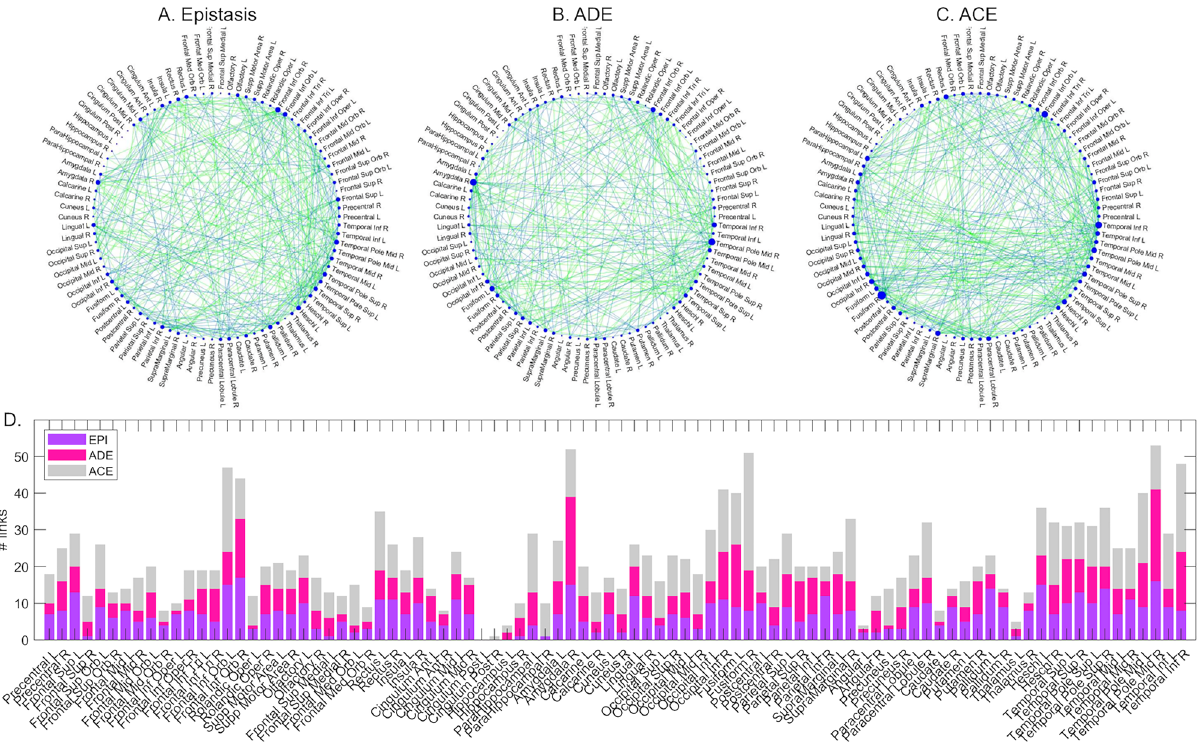
Figure 2. Twin models on link-level FC metrics. A-C. Graphs representing the brain functional connections influenced by epistasis ( A ), ADE factors ( B ), and ACE factors ( C ). Intra-hemispheric and inter-hemispheric connections are represented in blue and green, respectively. The size of each ROI (node) in the graph is proportional to the number of ROI connections influenced by the corresponding factor. D. Stacked bar plot representing the numbers of links per node influenced by epistasis (violet), ADE factors (magenta), and ACE factors (grey). FC: functional connectivity. ROI: region of interest. Panels were created with Matlab R2019b software (http:// www. mathw orks. com), assembled with Microsoft Power Point software (https:// www. micro soft. com/ it- it/ micro soft- 365/ power point) and exported using GIMP v.2–10 (https:// www. gimp. The comparison between r MZ and r DZ values based on Fisher’s Z-transform revealed significant differences, even if at the uncorrected level (p unc < 0.05), in 13.79% of the network links showing epistatic effects (highlighted in blue for the top 20 ROIs in Fig. 3A). Right middle temporal pole was the ROI with the highest number of links being significantly more correlated in MZ twins than in DZ twins (n = 11). The highest correlation difference was observed in the connection between right middle temporal pole and right precentral gyrus (Z = 2.94, p = 0.0016). ADE model. The functional connections influenced by both additive and dominant genetic factors accounted for 7.14% of the total number of links, balanced between intra-hemispheric (48.95%) and inter-hemispheric (51.05%) ones. The number of links per ROI influenced by ADE factors ranged from 0, in the bilateral posterior cingulate cortex and right parahippocampal gyrus, to 25 (28.09%), in the right middle temporal pole (Fig. 3B). The right amygdala showed the second highest percentage of links suitable for ADE modelling (n = 24, 26.97%). Based on the Fisher’s Z statistics, significant correlation differences between MZ and DZ pairs emerged, only at the uncorrected level, in 4.20% of these links (p unc < 0.05, highlighted in blue for the top 20 ROIs in Fig. 3B). Again, the right middle temporal pole showed the highest number of connections for which r MZ was significantly higher than r DZ (n = 9). The most significant Z statistics (i.e., correlation difference) was observed in its connec- tion with the right middle cingulate cortex (Z = 2.59, p = 0.005). The “broad-sense” heritability estimates ( H 2 = A + D ) for these links indicated an average predominance of environmental effects (E = 63.38 ± 16.19%) over genetic ones ( H 2 = 36.62 ± 16.19%). The links with H 2 > 50% accounted for 18.88% of the total (highlighted in red in Fig. 3D), whereas the remaining links showed predomi- nant E effects (highlighted in cyan in Fig. 3E). The H 2 maximum was observed in the connection between right middle temporal pole and right middle cingulate cortex (corresponding to the peak Z statistic). ACE model. The links meeting the ACE model criteria represented 9.61% of the total. Among them, intra- hemispheric and inter-hemispheric links were roughly balanced, accounting for 48.83% and 51.17%, respec- tively. The number of ROI connections affected by ACE factors varied from 0 in the left posterior cingulate cortex to 32 (35.96%) in the right fusiform gyrus (Fig. 3C). Proportions of these links higher than 20% were also observed in the right inferior temporal gyrus, left inferior orbitofrontal cortex, and left middle temporal pole.